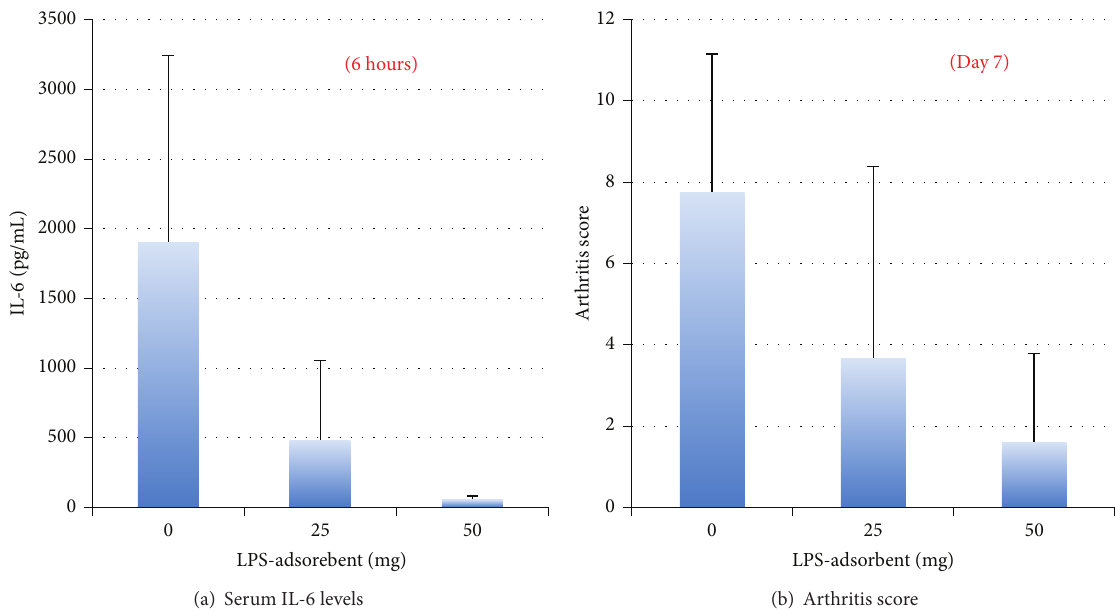
Figure 4: Synergistic effect of bacterial toxins and autoantibodies to type II collagen in induction of arthritis in mice. Oral administration of LPS in mice receiving a subarthritogenic dose of monoclonal antibody cocktail displayed an immediate increase in serum IL-6 levels and induced arthritis within 24–48 hours, reaching a maximum score on days 7-8. Co-oral administration of LPS-adsorbent prevents the increase of serum IL-6 and development of arthritis in a dose-dependent manner. Note . Serum IL-6 level was increased only in old mice more than 8 months but was not observed in young